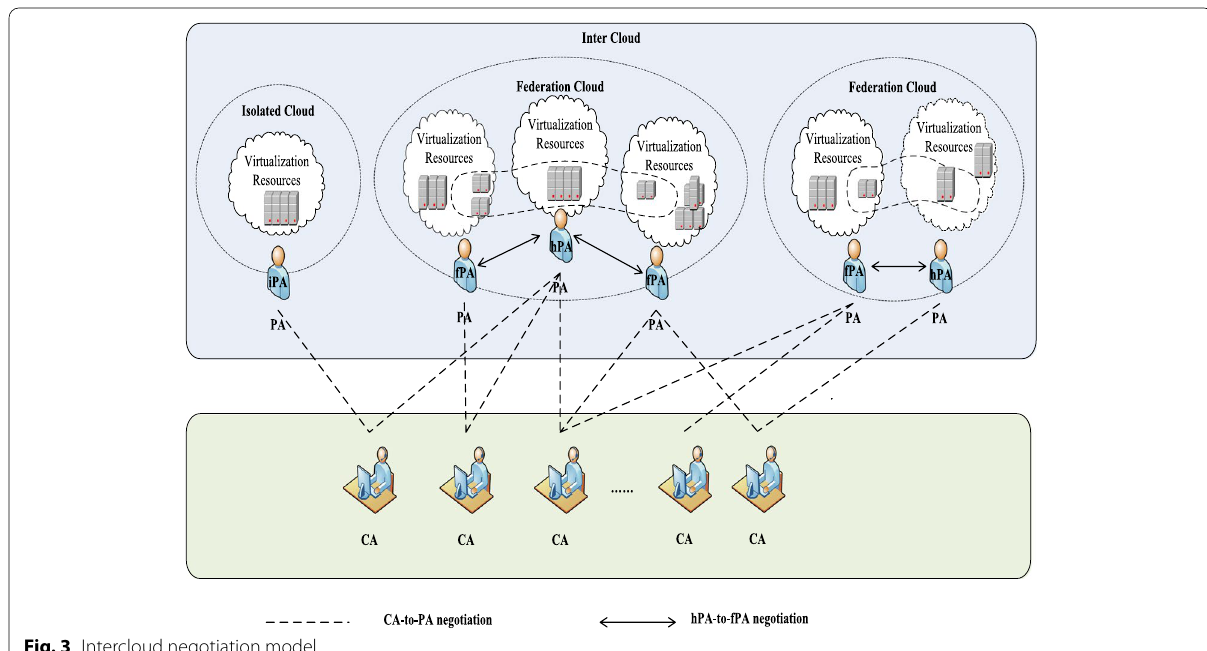
Fig. 3 Intercloud negotiation